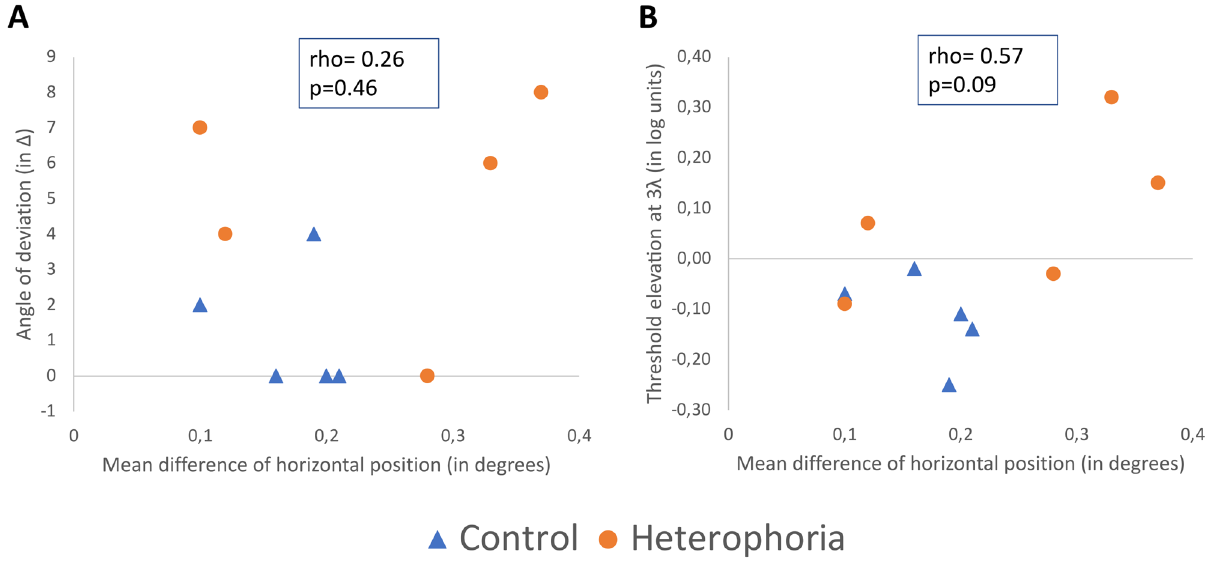
Figure 7. ( A ). Correlation between the angle of deviation (in Δ) and the mean difference in the horizontal position between the two eyes (in degrees). ( B ) Correlation between the threshold elevation at 3λ (in log units) and the mean difference in the horizontal position between the two eyes (in degrees). In both graphs, the blue triangle denotes controls and the orange circle denotes the heterophoric